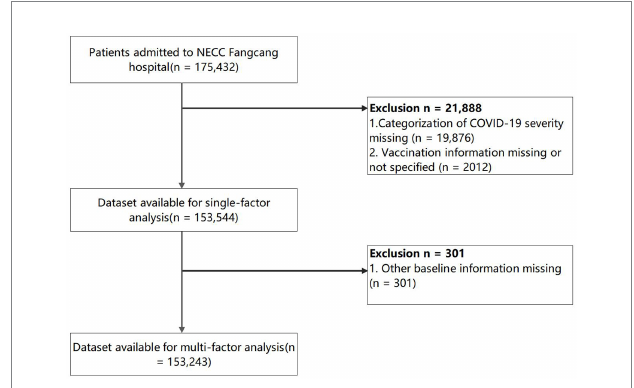
FIGURE 1 Flow chart of NECC Fangcang hospital data